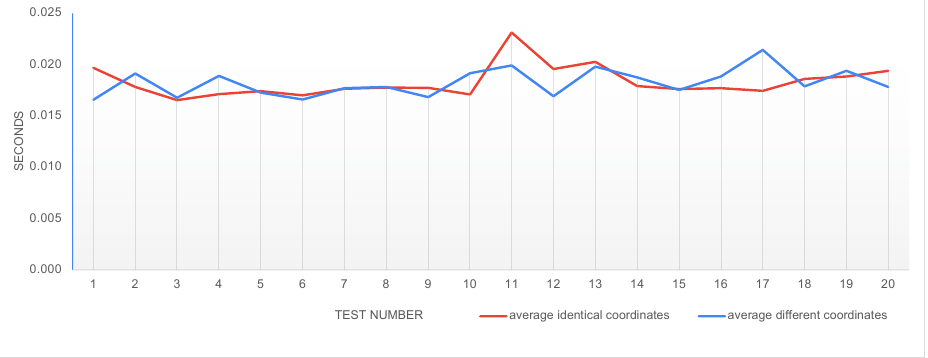
Figure 13. Side to side comparison of the average request response time per iteration of each